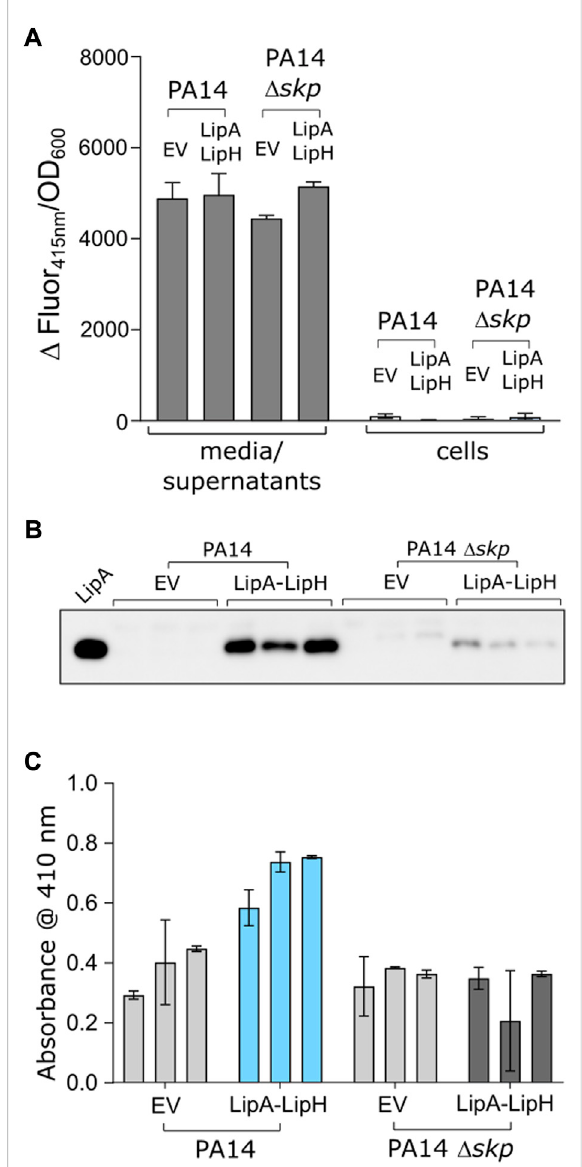
FIGURE 6 Deletion of skp gene in P. aeruginosa abolishes LipA secretion. (A) The functionality of P. aeruginosa T2SS is not affected by deletion of skp gene. Hydrolysis of Abz-Ala-Gly- Leu-Ala- p -nitro-benzyl-amide substrate by T2SS- dependent elastase was monitored as an increase in fl uorescence at 415 nm in the cell-free media and in cells of P. aeruginosa strains PA14 and PA14 Δ skp carrying the empty vector (EV, pGUF) and LipA-LipH expression vector, as described. (B) Western blot against the secreted LipA in P. aeruginosa . Wild-type PA14 and skp null-mutant (PA14 Δ skp ) strains were transformed with either an empty vector ( “ EV ” ) or a plasmid encoding for lipA-lipH operon ( “ LipA-LipH ” ). Recombinantly expressed and puri fi ed LipA was used as a reference (left lane). The complete western blot is provided in Suppl. Figure 3A. (C) Lipolytic activity against p NPB measured in the extracellular media of P. aeruginosa PA14 strains described in the panel